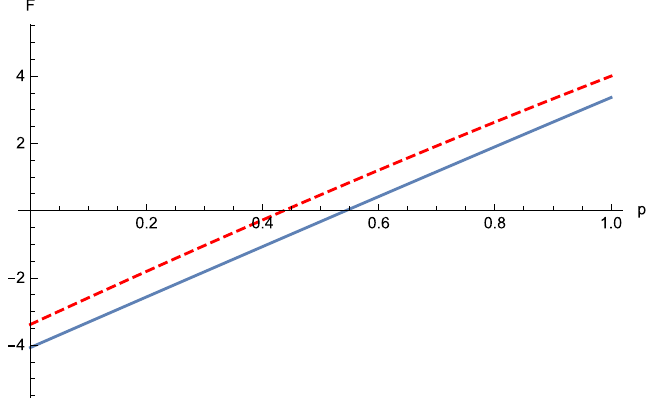
123 4 | ρ 2 0.3605 , ≤